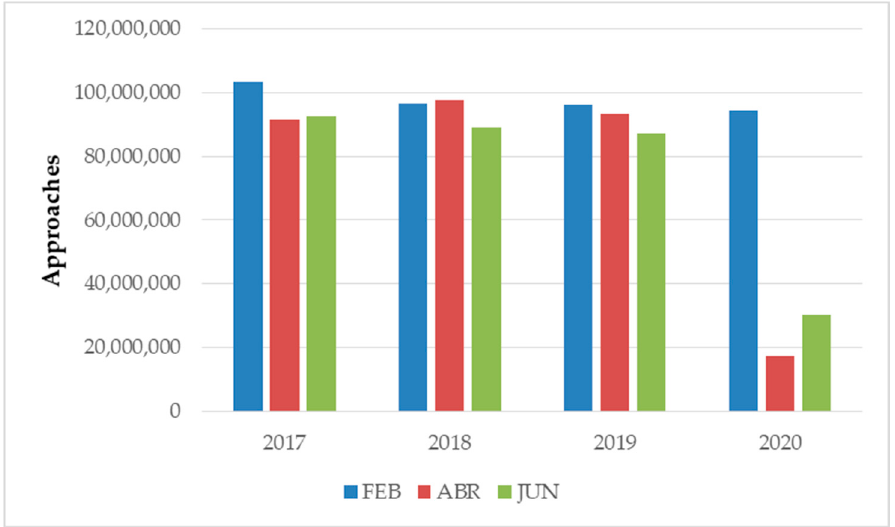
Figure 10. Validations in the BRT Transmilenio (Bogotá, Colombia) in the months of February, April and June, from the years 2017 to 2020.